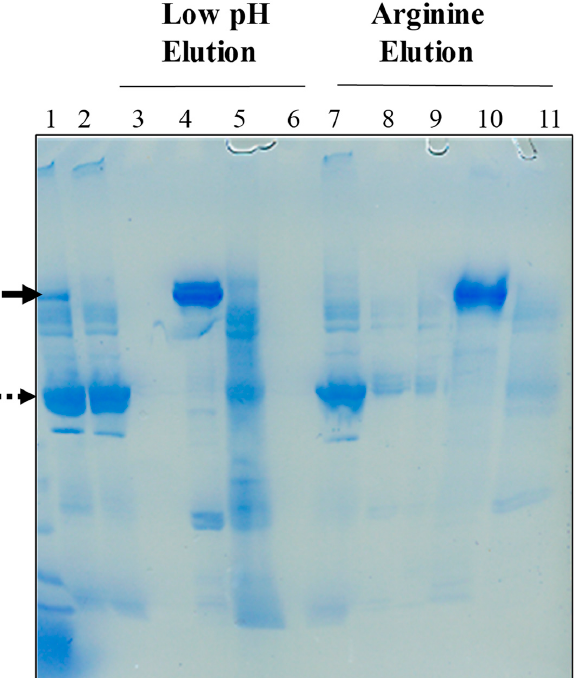
Figure 9. MEP chromatography of mAb-IL8 CM containing BSA. CM was spiked with BSA. Bound proteins were eluted with vendor’s protocol (lane 4 and 5) or the current protocol (lane 7–9). IL8-mAb is shown by a thick arrow and BSA by a dotted arrow. Lanes in SDS-PAGE: 1, Load; 2, FT; 3, 100 mM acetate/0.5 M NaCl, pH 5.5; 4, 50 mM acetate, pH 5.0; 5, 0.1 M citrate, pH 3.0 (vendor’s protocol). Arginine elution: lane 7, FT; 8, 25% 2-propanol/0.1 M NaCl, pH 7.0; 9, 35% EG, pH 7.0; 10, 1 M arginine, pH 7.0; 11, 0.1 M citrate, pH 3.0.